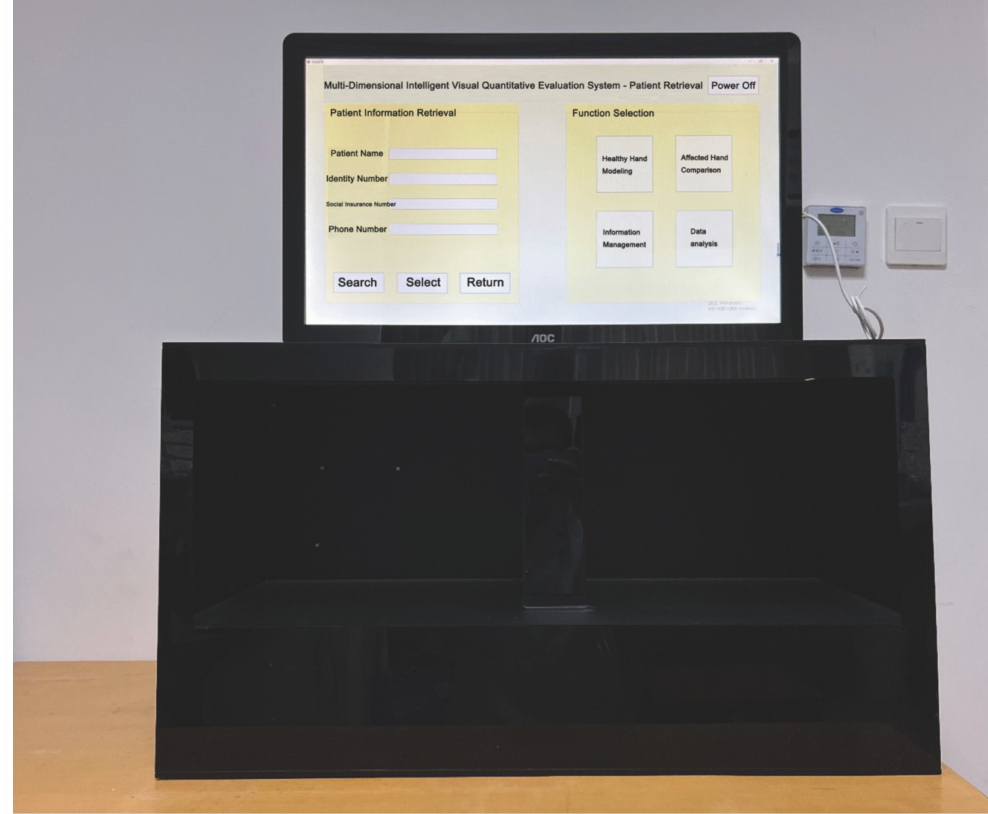
Figure 4. Hardware platform prototype of